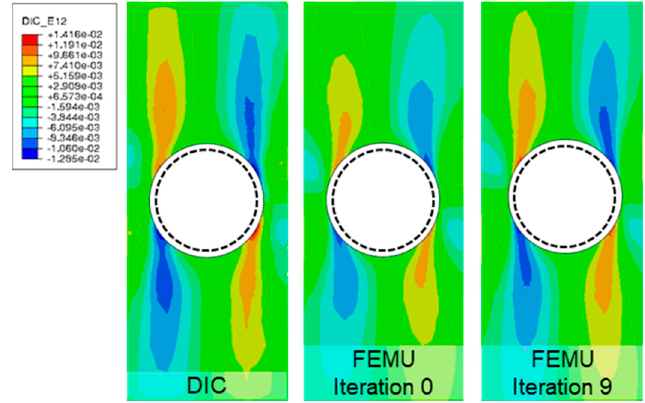
Figure 13. Comparison of DIC-measured interlaminar shear strains with FE results from the OHC-ILT FEMU procedure before (iteration 0) and after optimization (iteration 9) of material parameters.